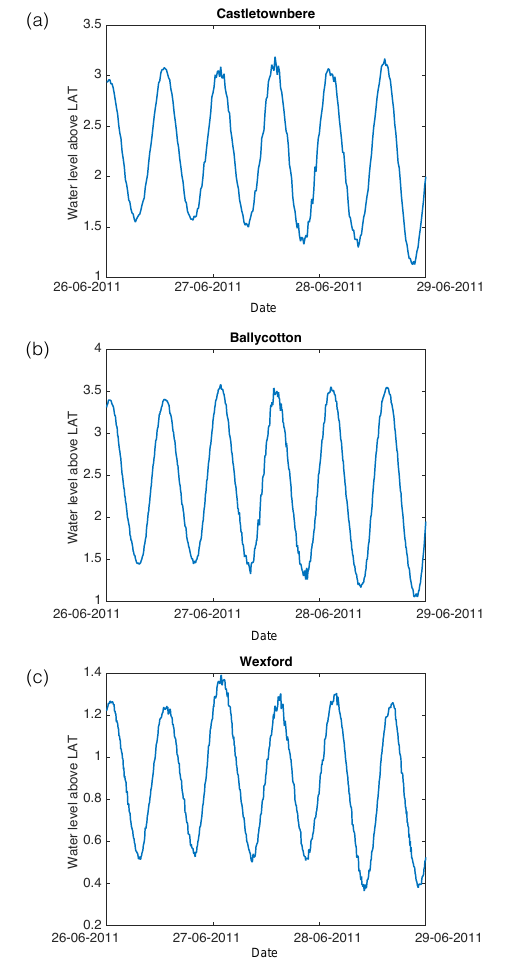
Figure 7. Tide gauge data from 26 to 29 June 2011 at (a) Castle- townbere (SW coast), (b) Ballycotton (S coast) and (c) Wexford (SE coast); small oscillations are clearly visible. Data retrieved from The Marine Institute (2017a).